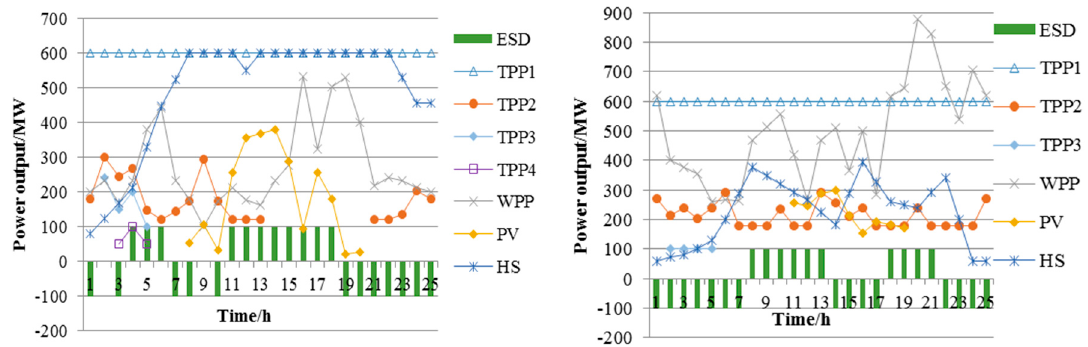
Figure 10. The MECS scheduling results on a typical day under the LLC mode: summer ( left ) and winter ( right ).